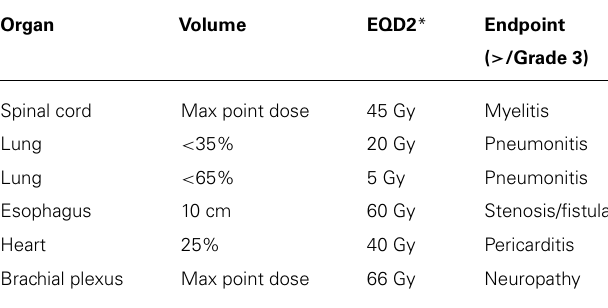
Table 2 | Cumulative dose constraints (EBRT and SBRT